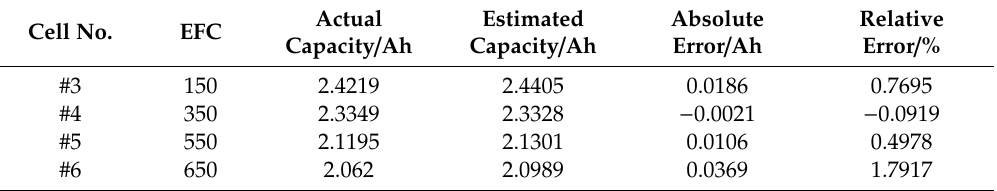
Estimated results of parameter–fusion estimation method at 40% SOC under discharging